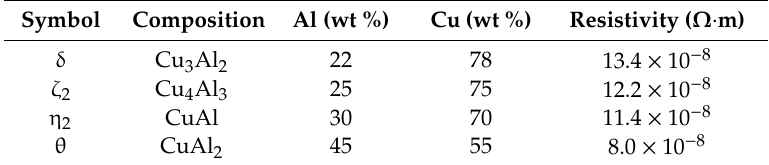
Table 11. Resistivity of aluminum / copper intermetallic compounds (data from reference